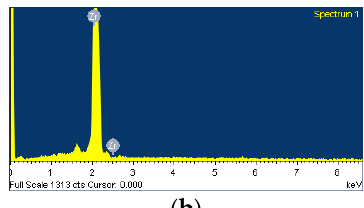
Figure 4. Energy dispersive X-ray spectroscopy (EDS) patterns of the zirconia disk compared with the Ti disk. ( a ) Control group = Ti disk; ( b ) Test group = zirconia disk.